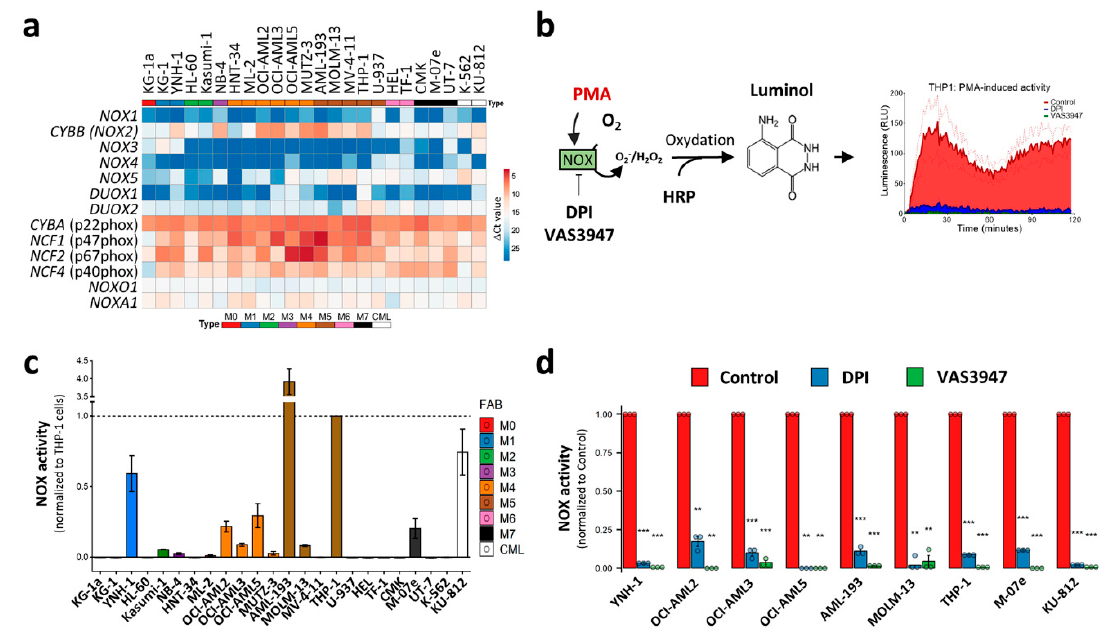
Figure 5. NOX expression and activity in 24 leukaemic cell lines. ( a ) The NOX mRNA expression profile in 22 AML and 2 CML-derived cell lines. The AML cell lines are organized from M0 to M7, according to the FAB classification. The NOX mRNA expression was assessed by RT-qPCR (mean values, N = 3). The heatmap colors reflect the expression level as ∆ Ct mean values (red: high expression, blue: low expression). ( b ) A schematic representation of the NOX enzymatic activity measurement. PMA induces the assembly of NOX2 complex and stimulates subsequent ROS production, allowing HRP oxidation. In its turn, HRP oxidizes luminol, which emits light that is measured during a 2 h period. ( c ) The PMA-inducible NOX enzymatic activity measurement (N = 3). The NOX activity is reported as area under the curve, normalized to that of THP1 cells. ( d ) The cells were incubated in the presence or absence of DPI (20 µ M). The data are shown as the area under the curve (mean ± SEM, N = 3). Student’s t-test was performed for each cell line, comparing the control to each of the DPI- and VAS3947-treated conditions (** p < 0.01; *** p < 0.001). RLU: relative luminescence